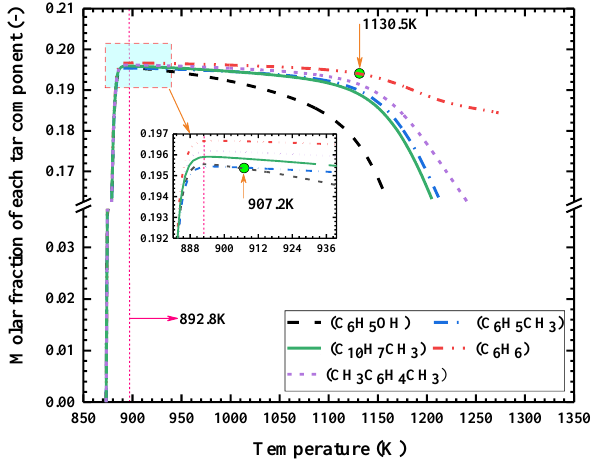
Figure 2. Variation of gas-phase tar with temperature with introduced Brown’s gas.